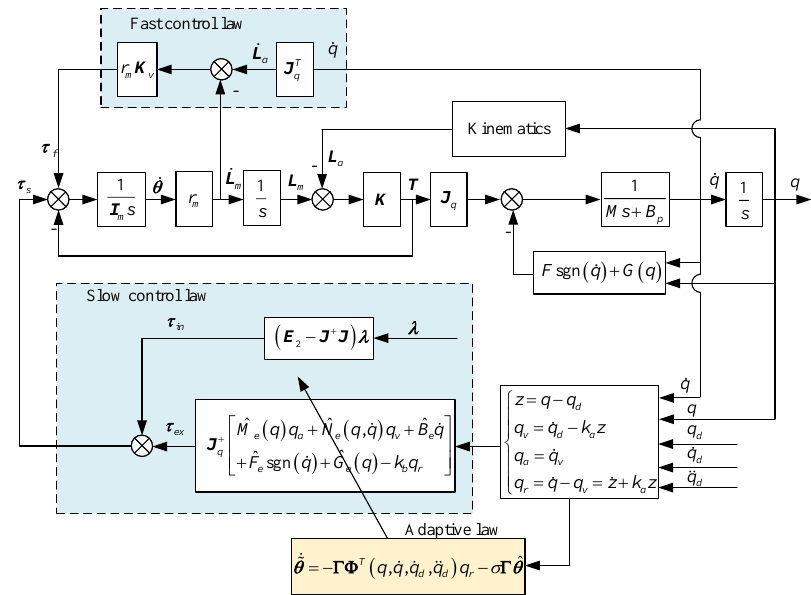
Figure 3. Control diagram of the composite adaptive